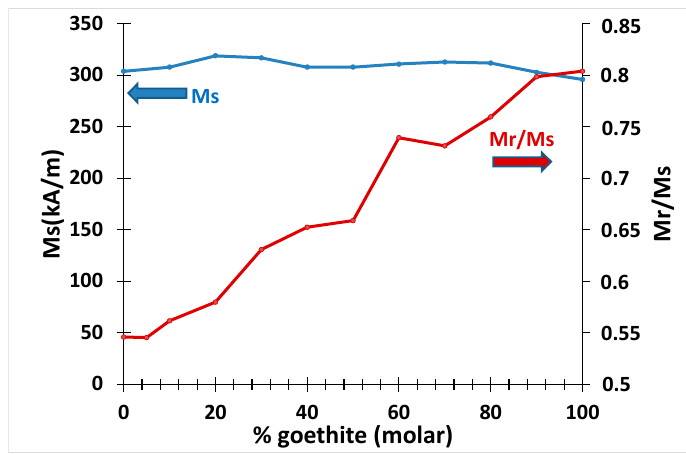
Figure 13 . Variations of the saturation magnetization (MS) and reduced ‐ remanence magnetization ( M R // / M S ) with the molar percentage of goethite.